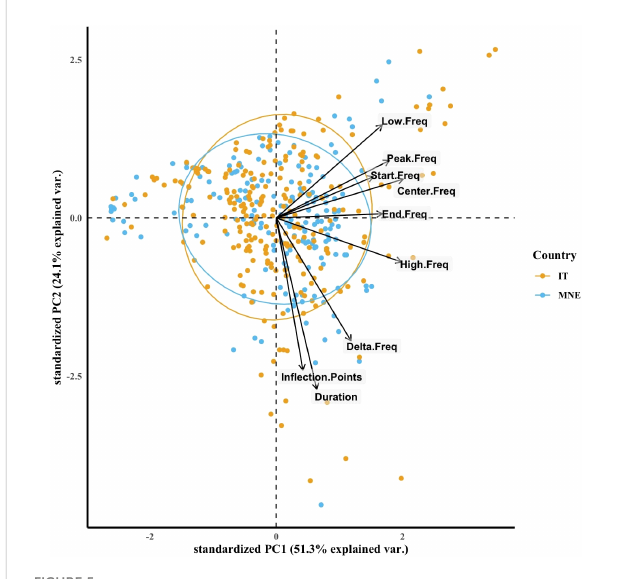
FIGURE 5 PCA correlation biplot of the whistle parameters grouped by the study location (IT = Taranto Gulf, MNE = Boka Bay) with 95% con fi dence interval ellipses.